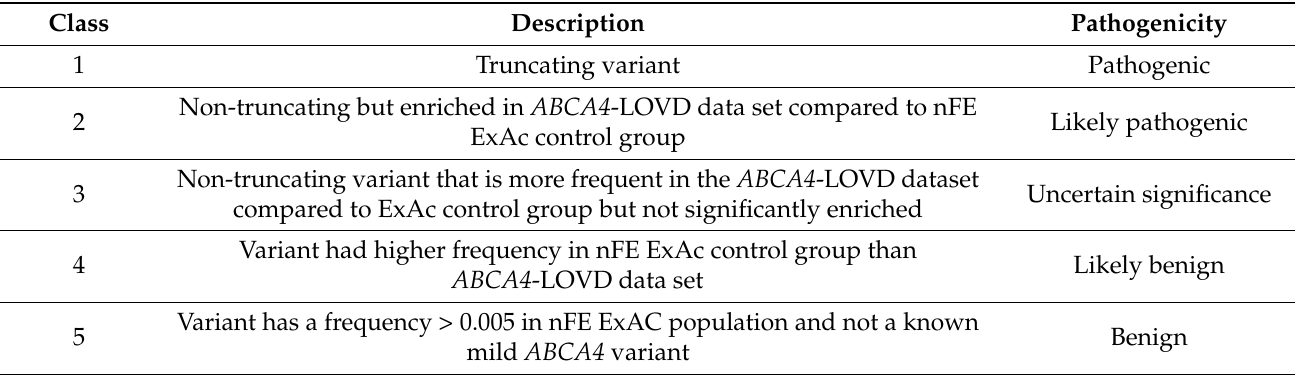
Table 4. Summary of the classification criteria used by Cornelis at al. to decide the genotype severity